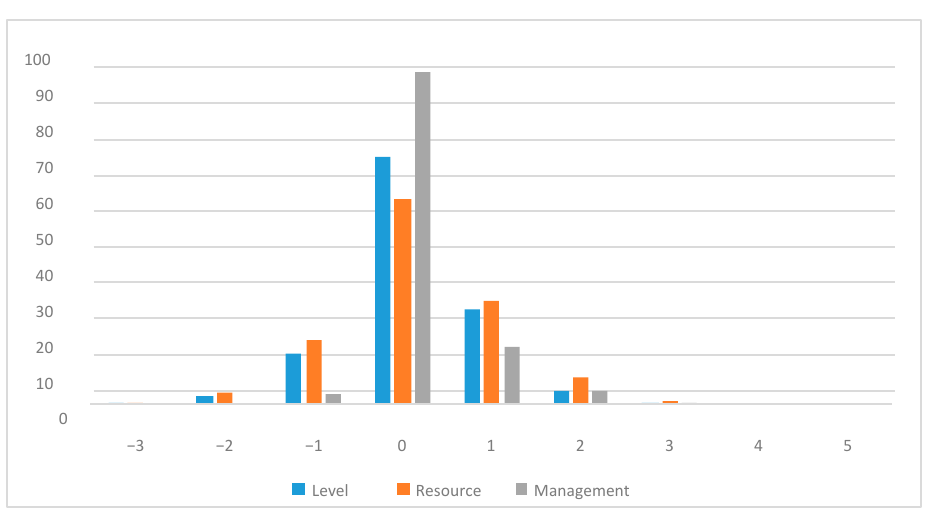
Figure 2. Generalized evaluation of the discrepancies’ impact on the task. The results of the survey provide an opportunity to address two issues. First, it is possible to determine whether workers consider the tasks adequate. Depending on this, conclusions can be drawn about the presence of hidden resistance and opportunistic behavior. The second question is the degree of unanimity in the workers’ attitude to the tasks. To evaluate the team’s opinion on the adequacy of the tasks, it is proposed to calculate the assessment as weighted, taking into account the impact of deviations from the maximum value: